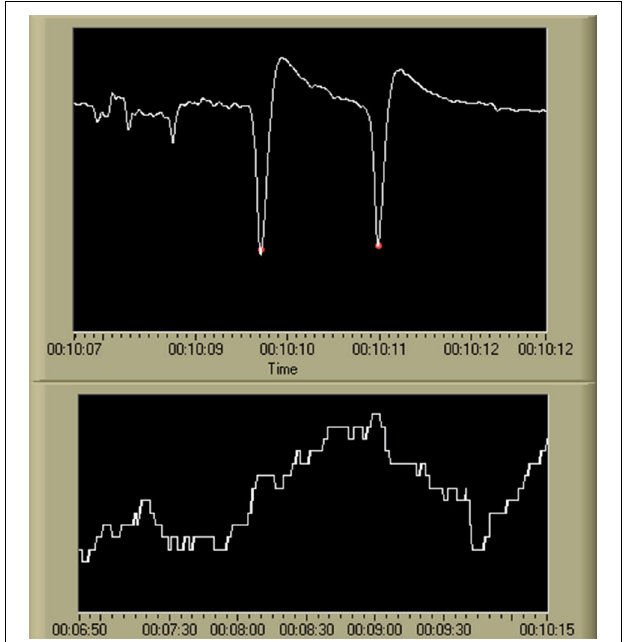
FIGURE 6 | Output of the blink detection algorithm (Kong and Wilson, 1998) and the resulting blink rate time series. Detected blinks are shown in the first chart using red marking indicators at the apex of each blink. The second chart displays the resulting blink rate time series. While not shown on the display, the scale for the VEOG time series is [uV], and the scale for the blink rate time series is [blinks/min]. The time scale is in standard HH:MM:SS format.